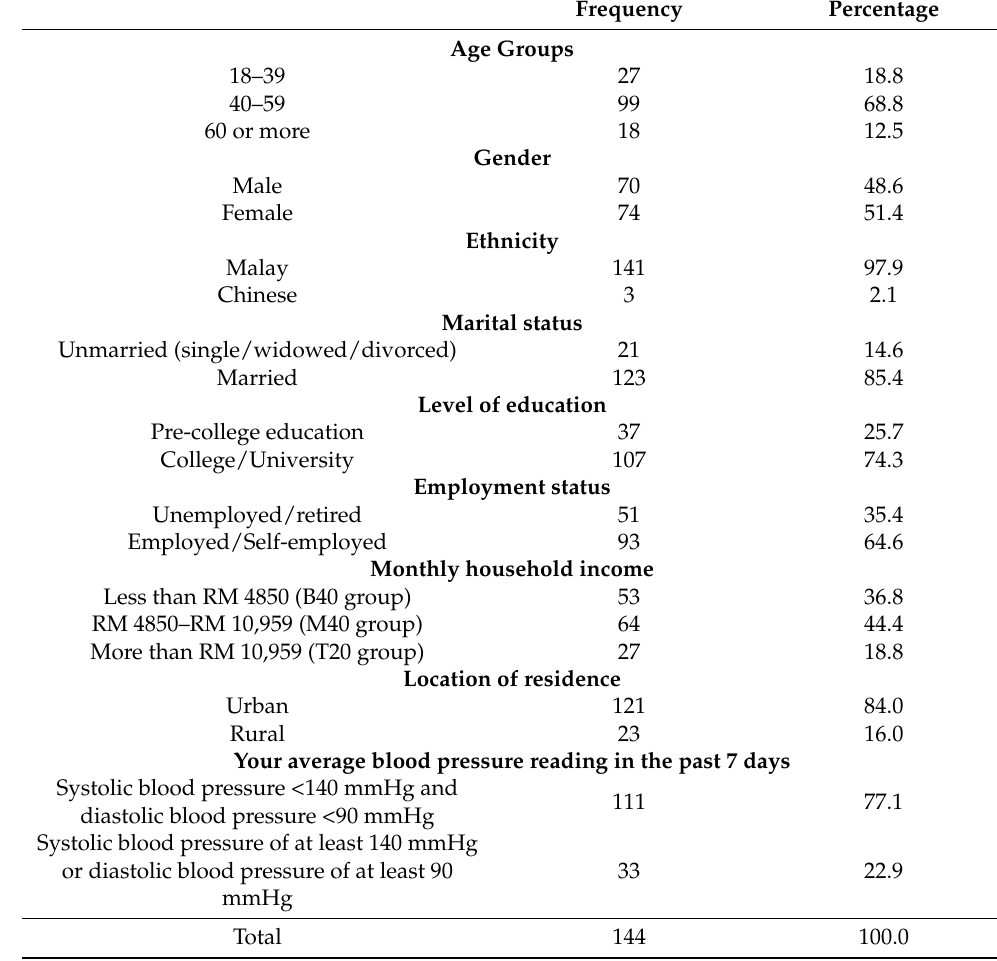
Table 1. Demographics of study participants and their BP control.